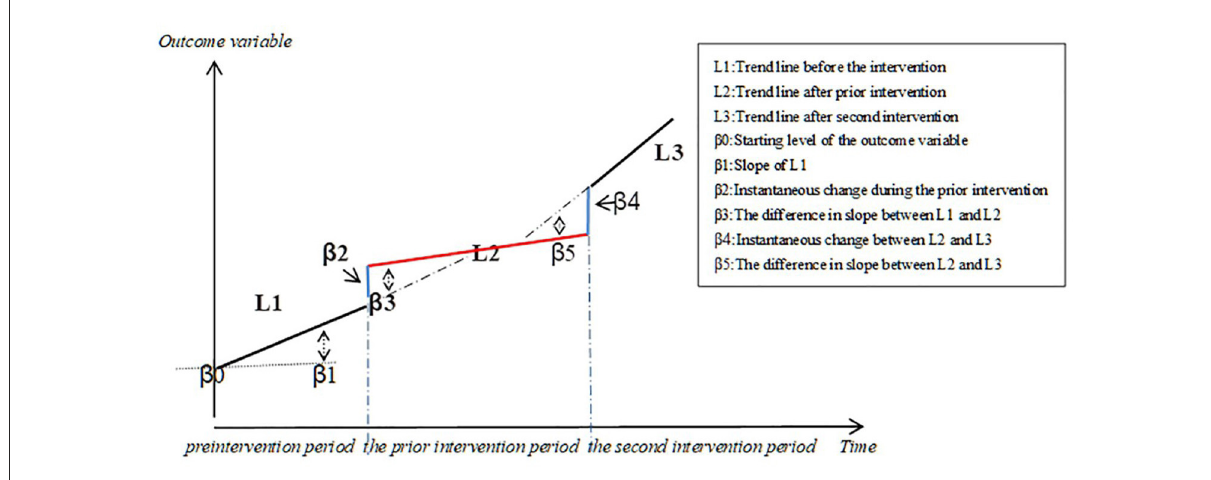
FIGURE1 Graphic illustration of the ITS model and the trend lines for data points before and after policy